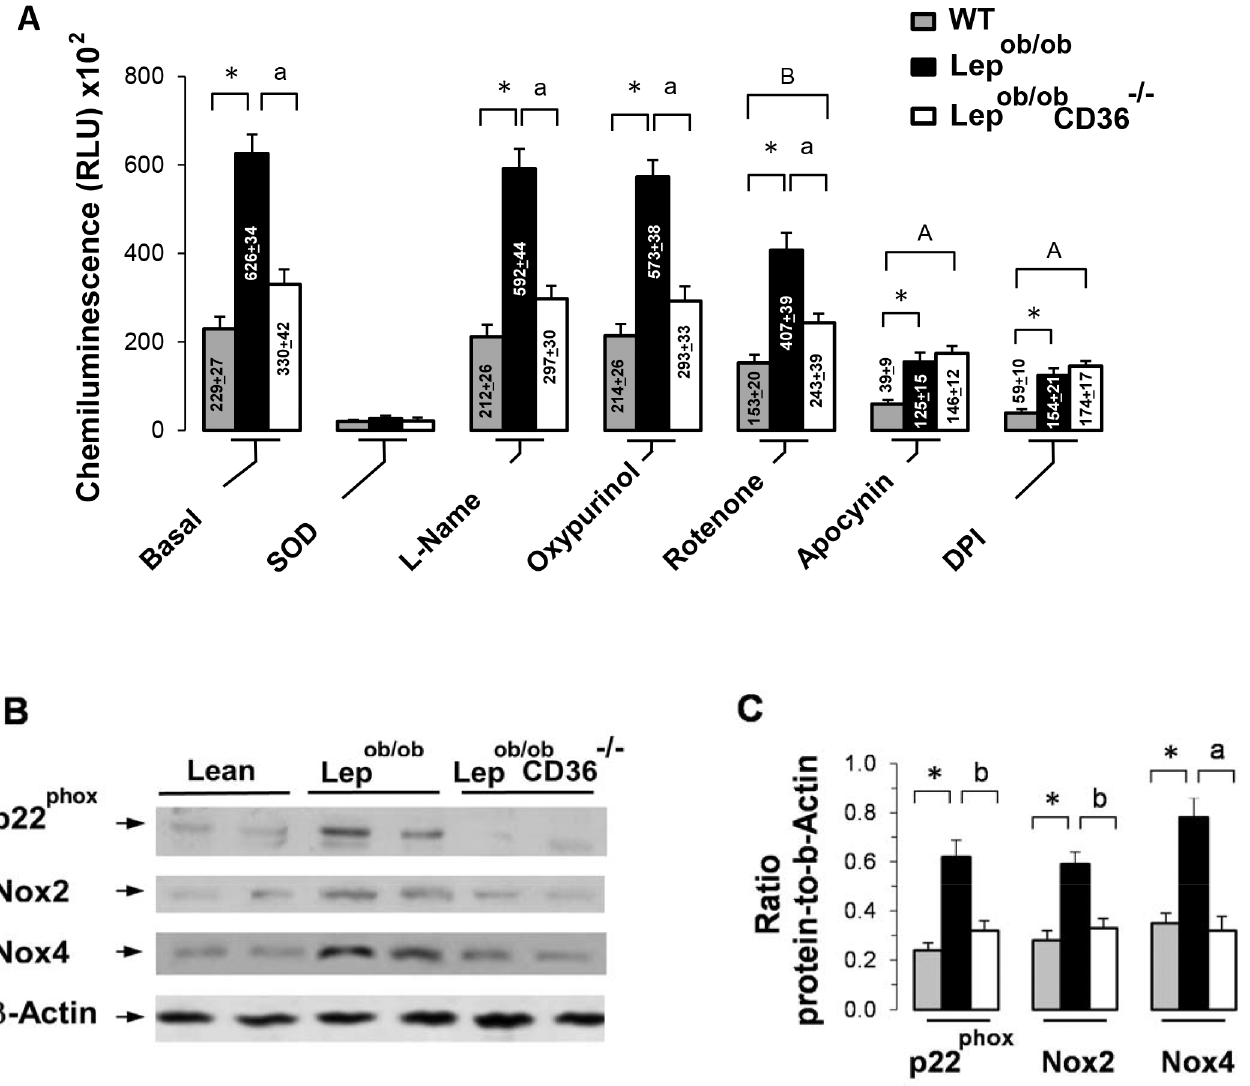
Fig 7. Effects of CD36 expression on NADPH-dependent superoxide production and expression of NADPH oxidase. A) NADPH- dependent and SOD-inhibitable superoxide was measured in heart homogenates by the lucigenin chemiluminescent method. Measurements were performed in preparations without inhibitors (basal) or in presence of superoxide dismutase (SOD) used to determine the specific of measurements, L-NAME (nitric oxide synthase inhibitor), Oxypurinol (oxidase inhibitor), Rotenone (complex I mitochondrial electron chain inhibitor), Apocynin (NADPH oxidase) and DPI (flavoprotein inhibitor). Measurements were conducted in triplicates from an n = 5 per group. B) Representative blots and C) ratio of p22 phox , NADPH oxidase 2 (Nox2) and 4 (Nox4) to β -actin. Results are presented as Mean ± SEM and differences between Lep ob/ob and Lean mice are indicated with asterisks with ** p < 0.01 and * p < 0.05. Differences between Lep ob/ob CD36 -/- and Lep ob/ob mice are indicated with alphabetic letters a p < 0.01 and b p < 0.05. Differences between Lep ob/ob CD36 -/- and Lean mice are indicated with A capital alphabetic letter A p <